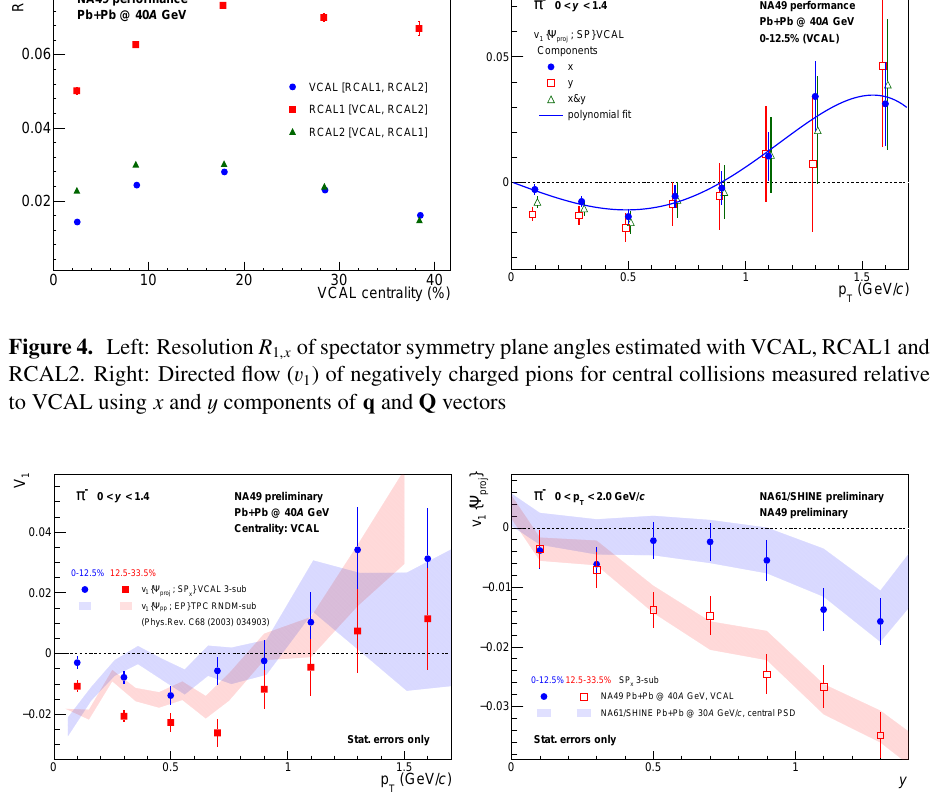
Figure 5. Directed flow ( v 1 ) of negatively charged pions in di ff erent centrality classes. Left: v 1 vs. transverse momentum ( p T ). Right: v 1 vs. rapidity ( y ). Only statistical errors are